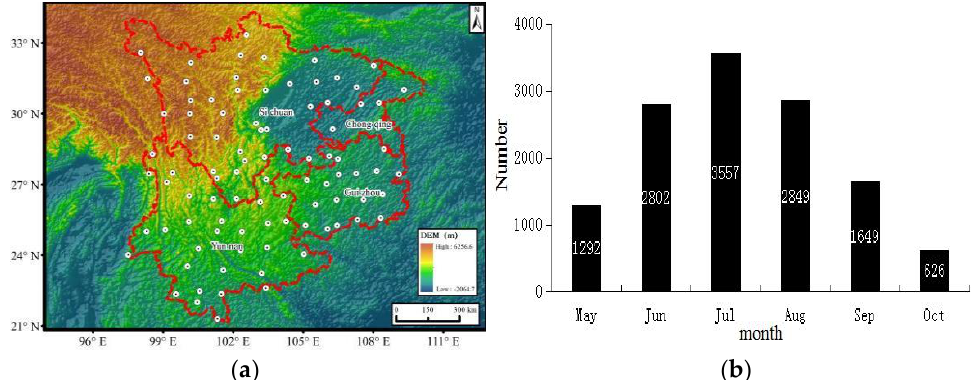
Figure 1. Distribution of the 90 surface meteorological observation stations ( a ) and the monthly cumulative frequency of rainstorms and floods during the 1961 – 2021 period ( b ).